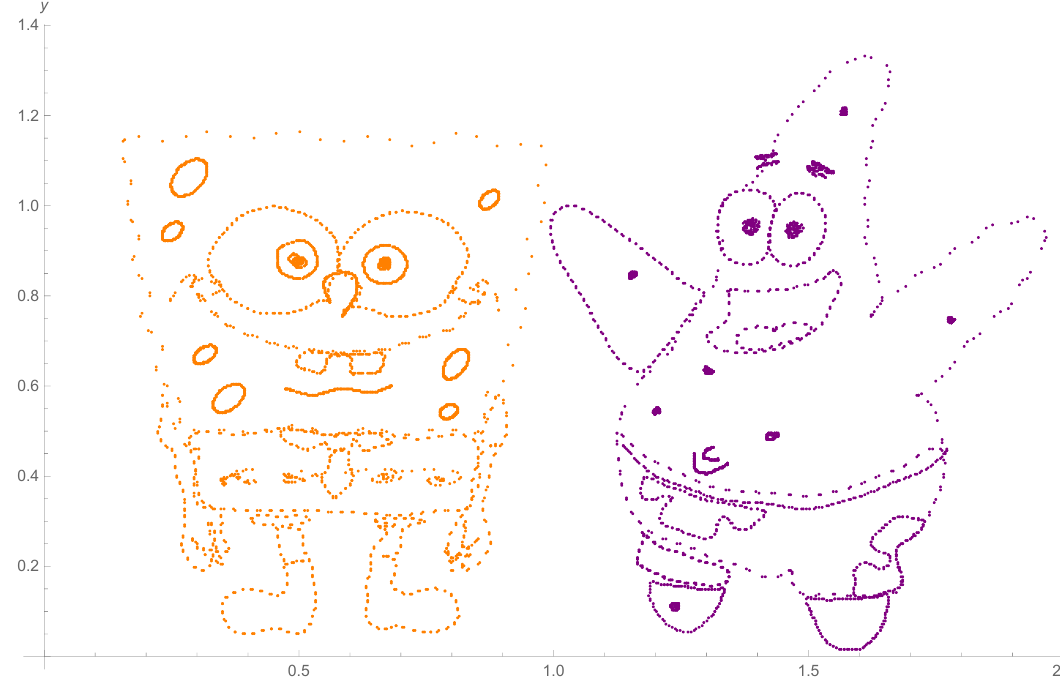
Figure 2 . Representation of the positions of the black holes, which are contained at the plane ~x = ( x; y; 0). The (cid:12)rst cluster is depicted by purple points, while the second is represented with orange